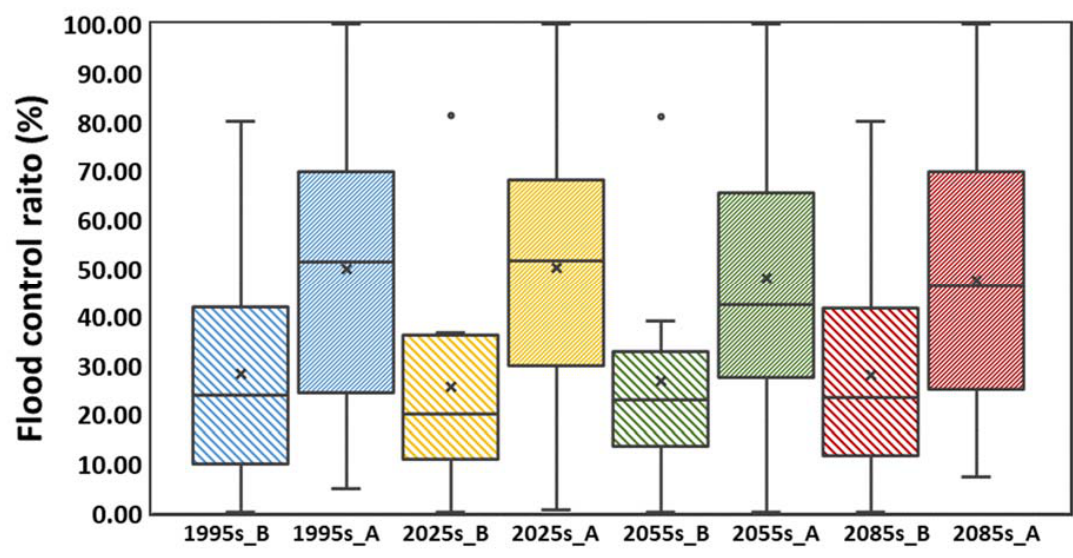
Figure 4. Box plots of flood control ratio before and after dam heightening by period. B stands for before dam heightening and A stands for after dam.